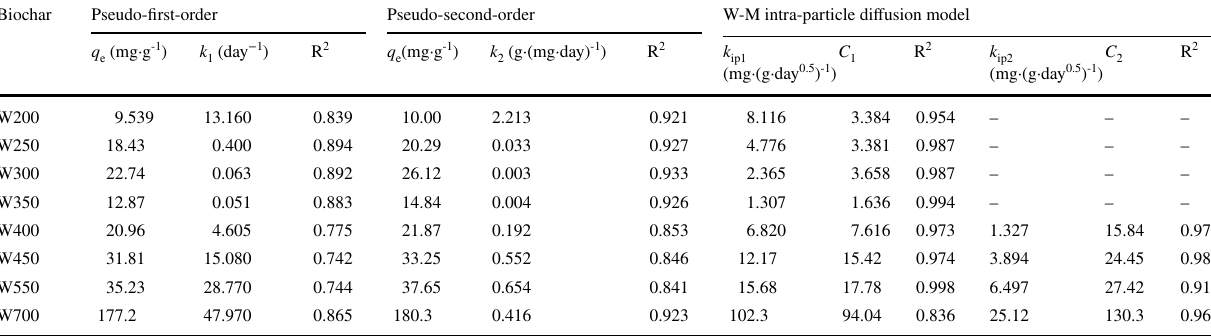
–The sorption kinetic process of 1,3,5-trinitrobenzene on W200, W250, W300 and W350 suggests matrix diffusion ( k ip1 ) and diffusion equilib- rium. Therefore, there was no k ip2 for the sorption of 1,3,5-trinitrobenzene on W200, W250, W300 and W350